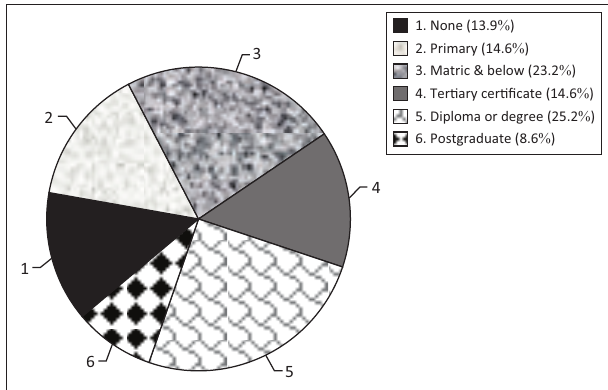
FIGURE 2: Age of